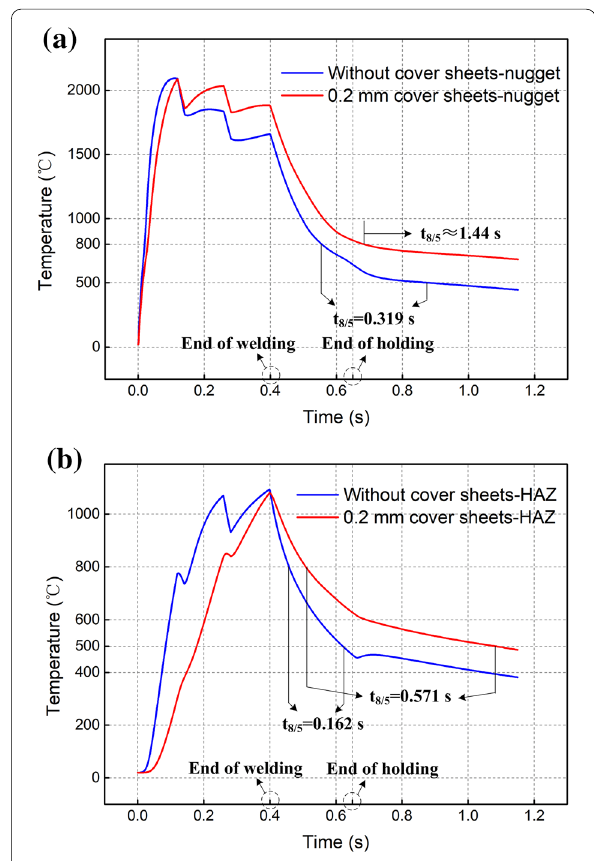
Figure 6 Calculated temperature histories at the ( a ) nugget and ( b ) HAZ of the joints without cover sheet and with 0.2 mm cover sheets under critical welding current obtained from FEM simulation